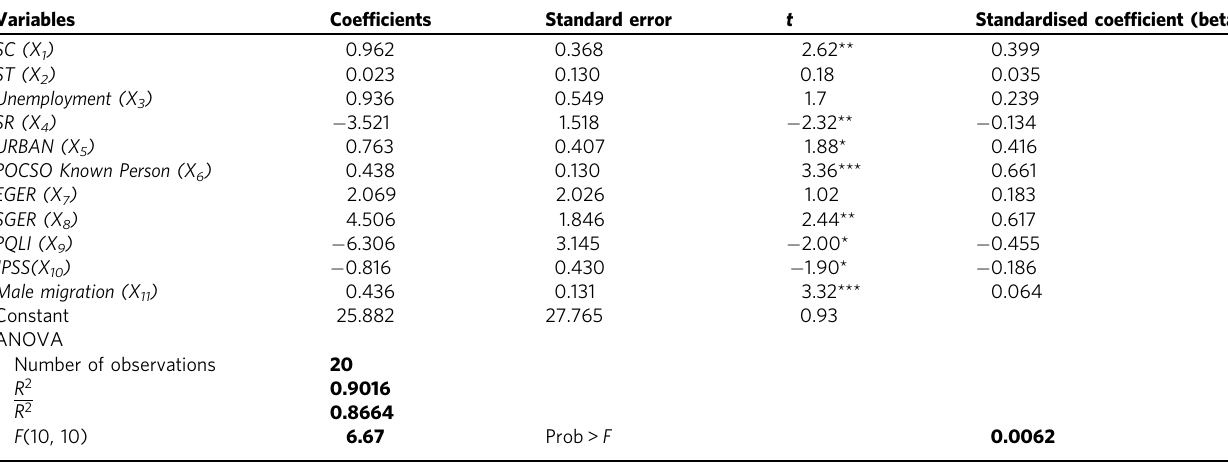
Table 6 Factors in fl uencing the rate of reported POCSO cases of different states as well as in India. Variables